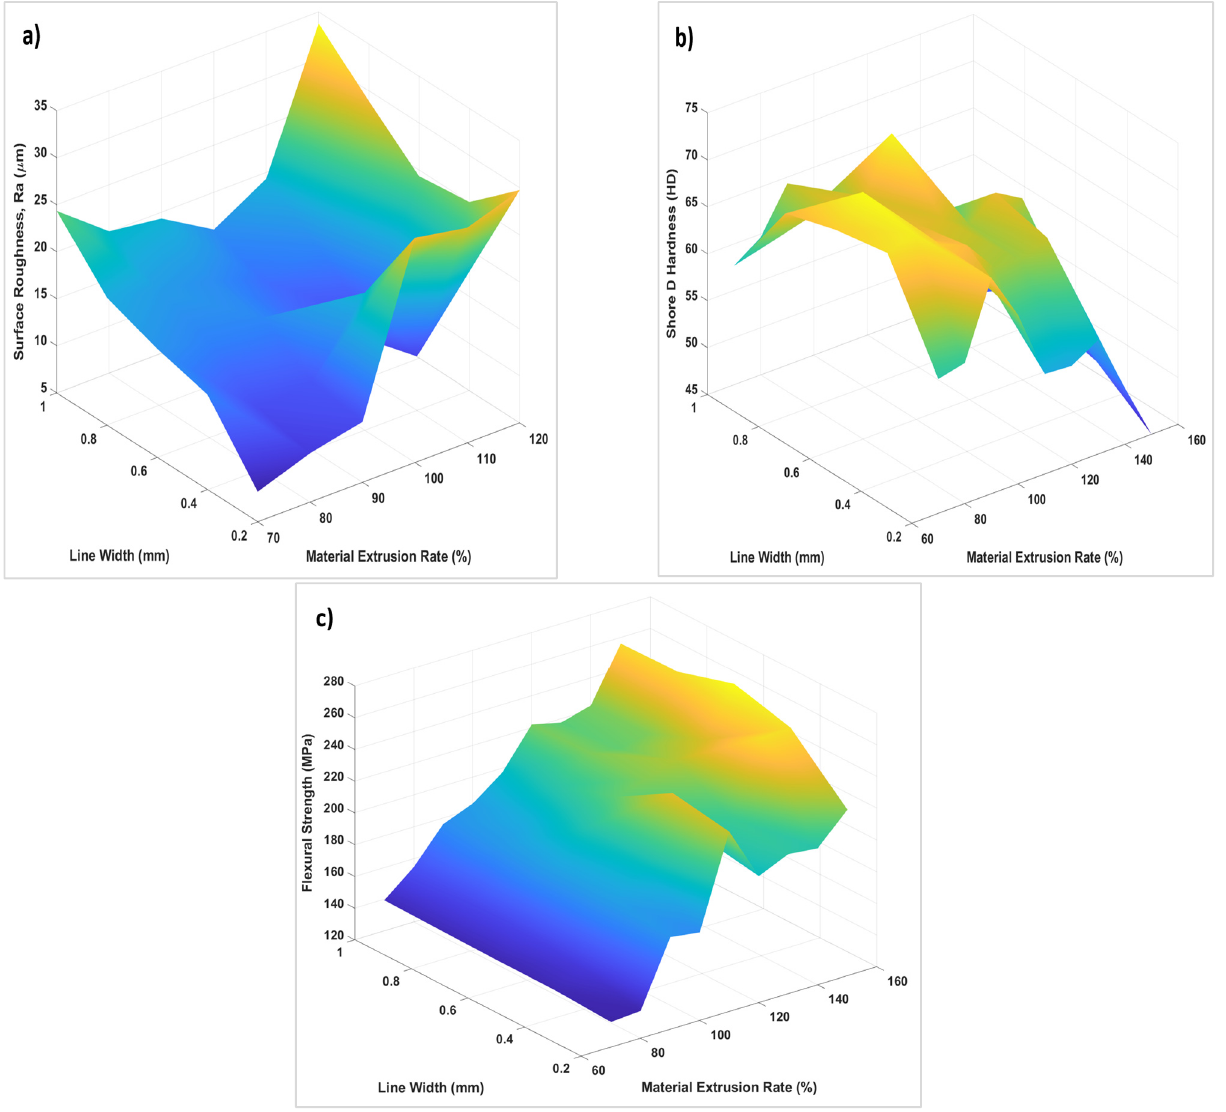
Figure 10. Surface plots: ( a ) average surface roughness; ( b ) average hardness; and ( c ) average flexural strength.